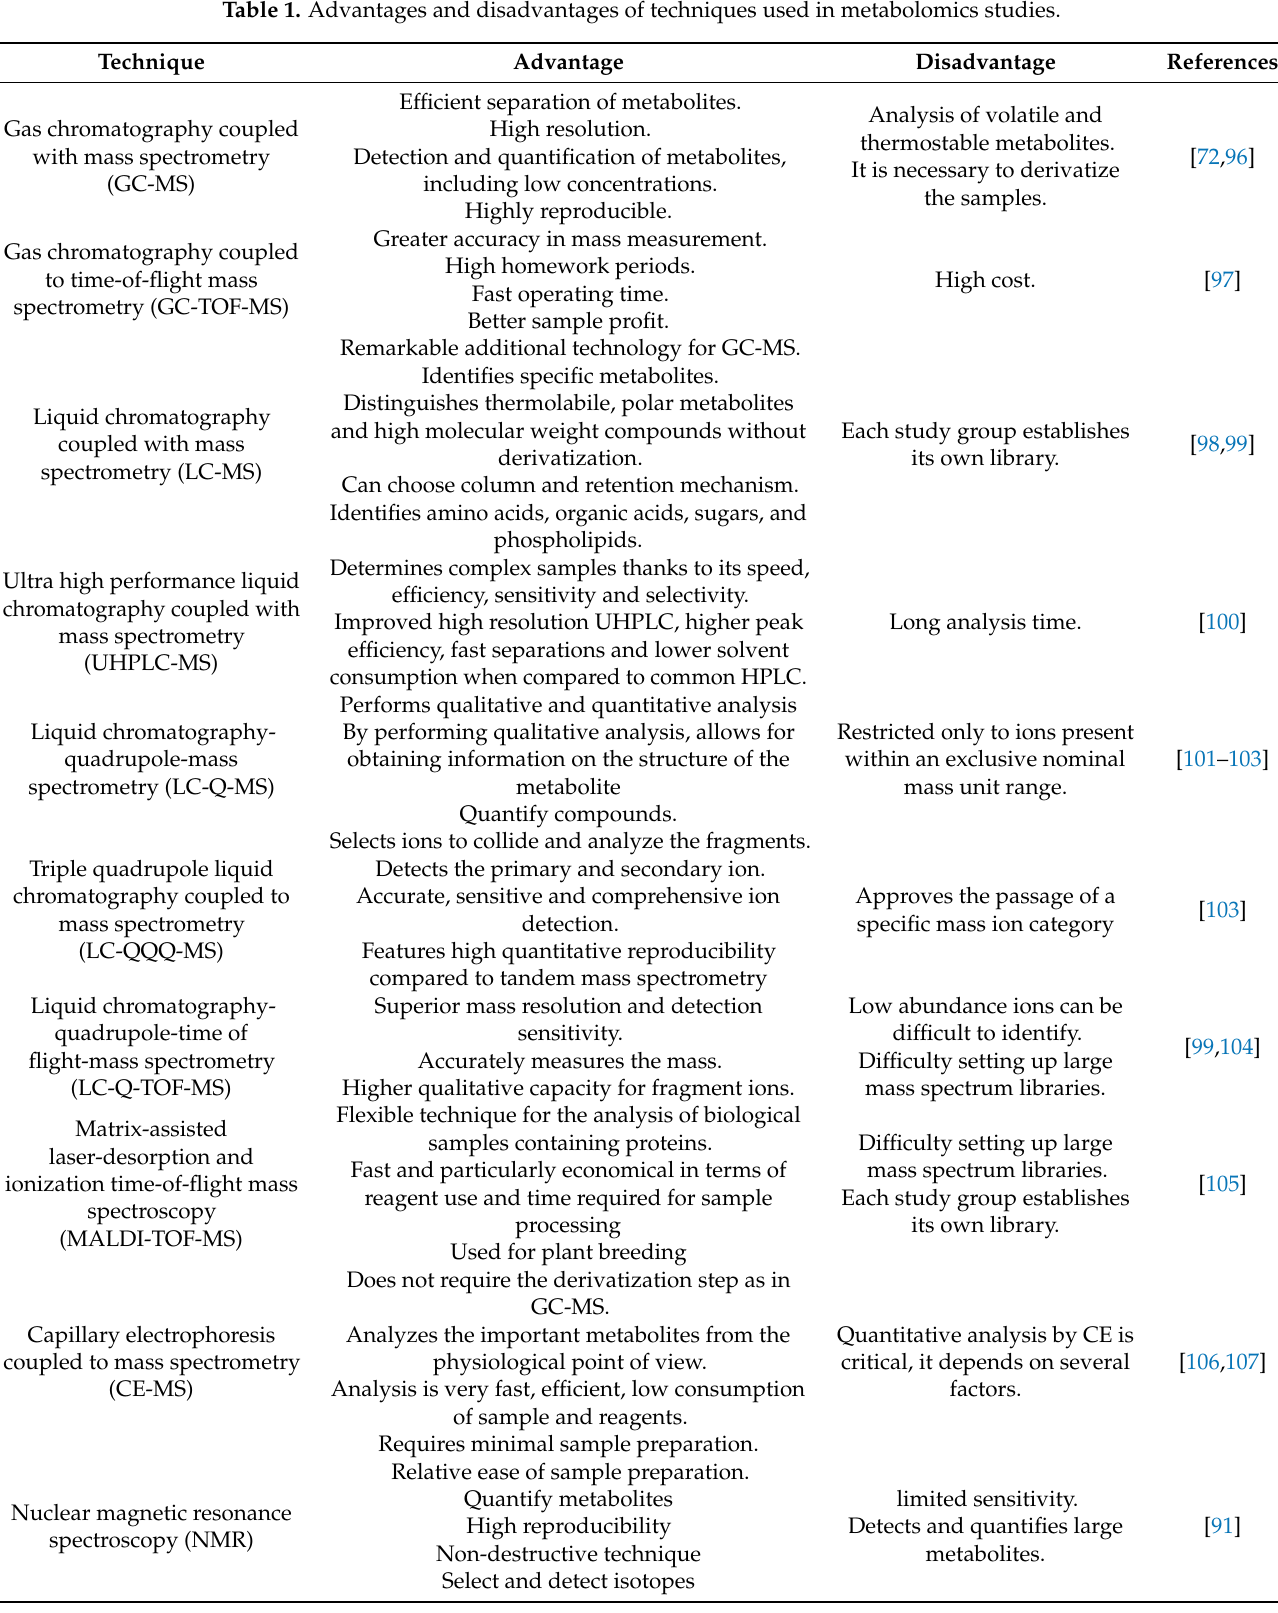
Table 1. Advantages and disadvantages of techniques used in metabolomics